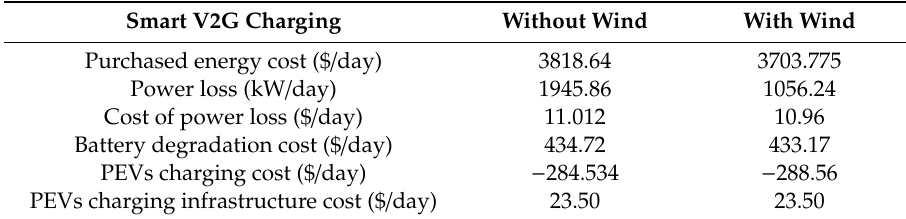
Table 5. Power loss and costs of smart V2G charging approach.